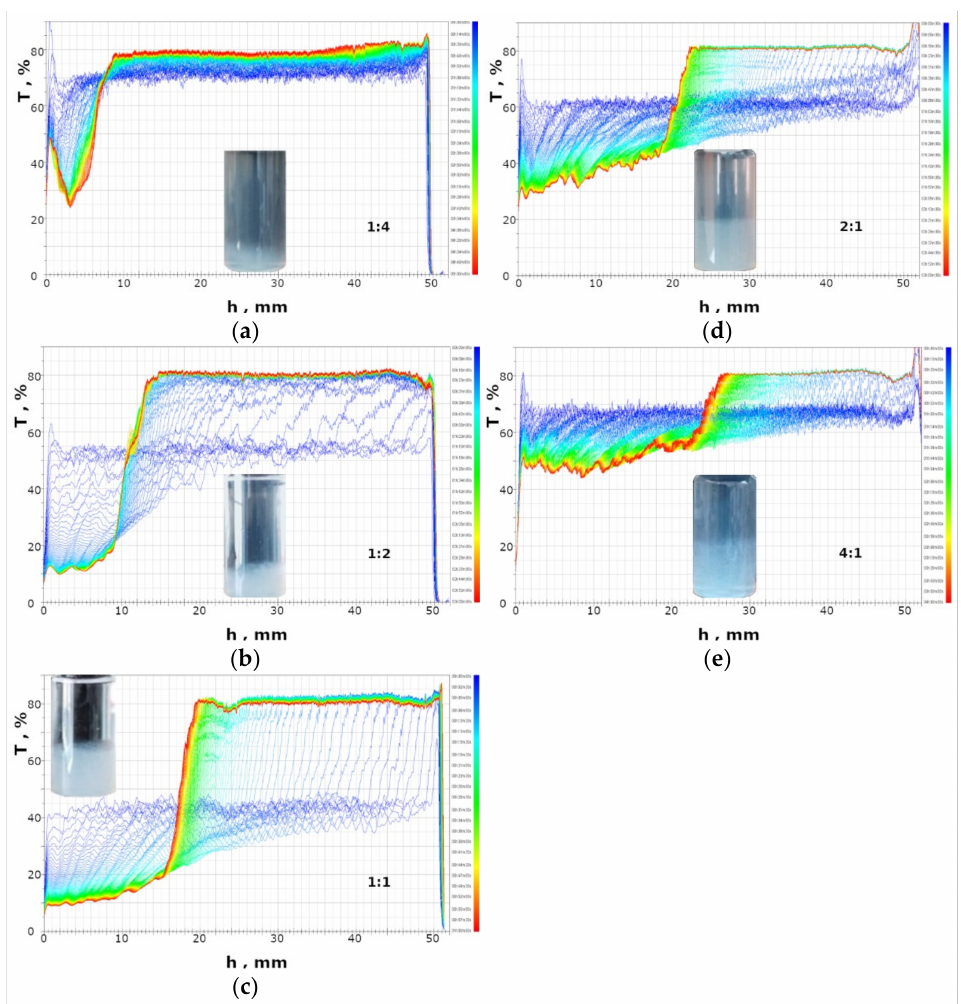
Figure 2. Light transmission profiles scanned along the height of the vial during the sedimentation run at the indicated polyDADMAC to carrageenan ratios: ( a ) 1:4, ( b ) 1:2, ( c ) 1:1, ( d ) 2:1, and ( e ) 4:1. The inserts visualize the appearance of the final